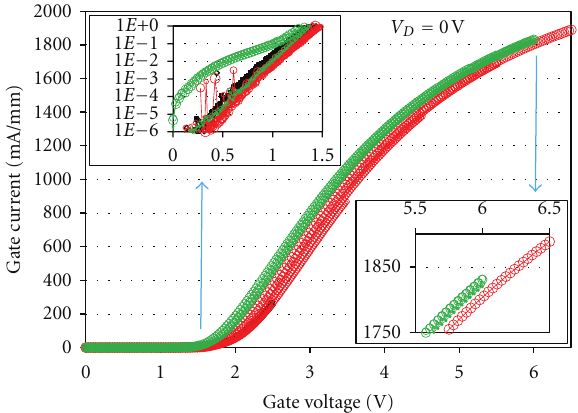
Figure 2: Gate diode curves during the stressing. Insets show additional detail for regions of interest of the same curves as the main plot and share the same units (i.e., mA/mm and V) as the main figure. The data were collected at stress times represented in Figure 1. Black curves represent the initial V G = +2.5 V gate stresses. Red curves represent the gate voltage stress ramps of increasing magnitude collected just prior to the red curves of Figure 1. Green curves are gate voltage stress ramps collected just after the total stress times represented by the green curves of Figure